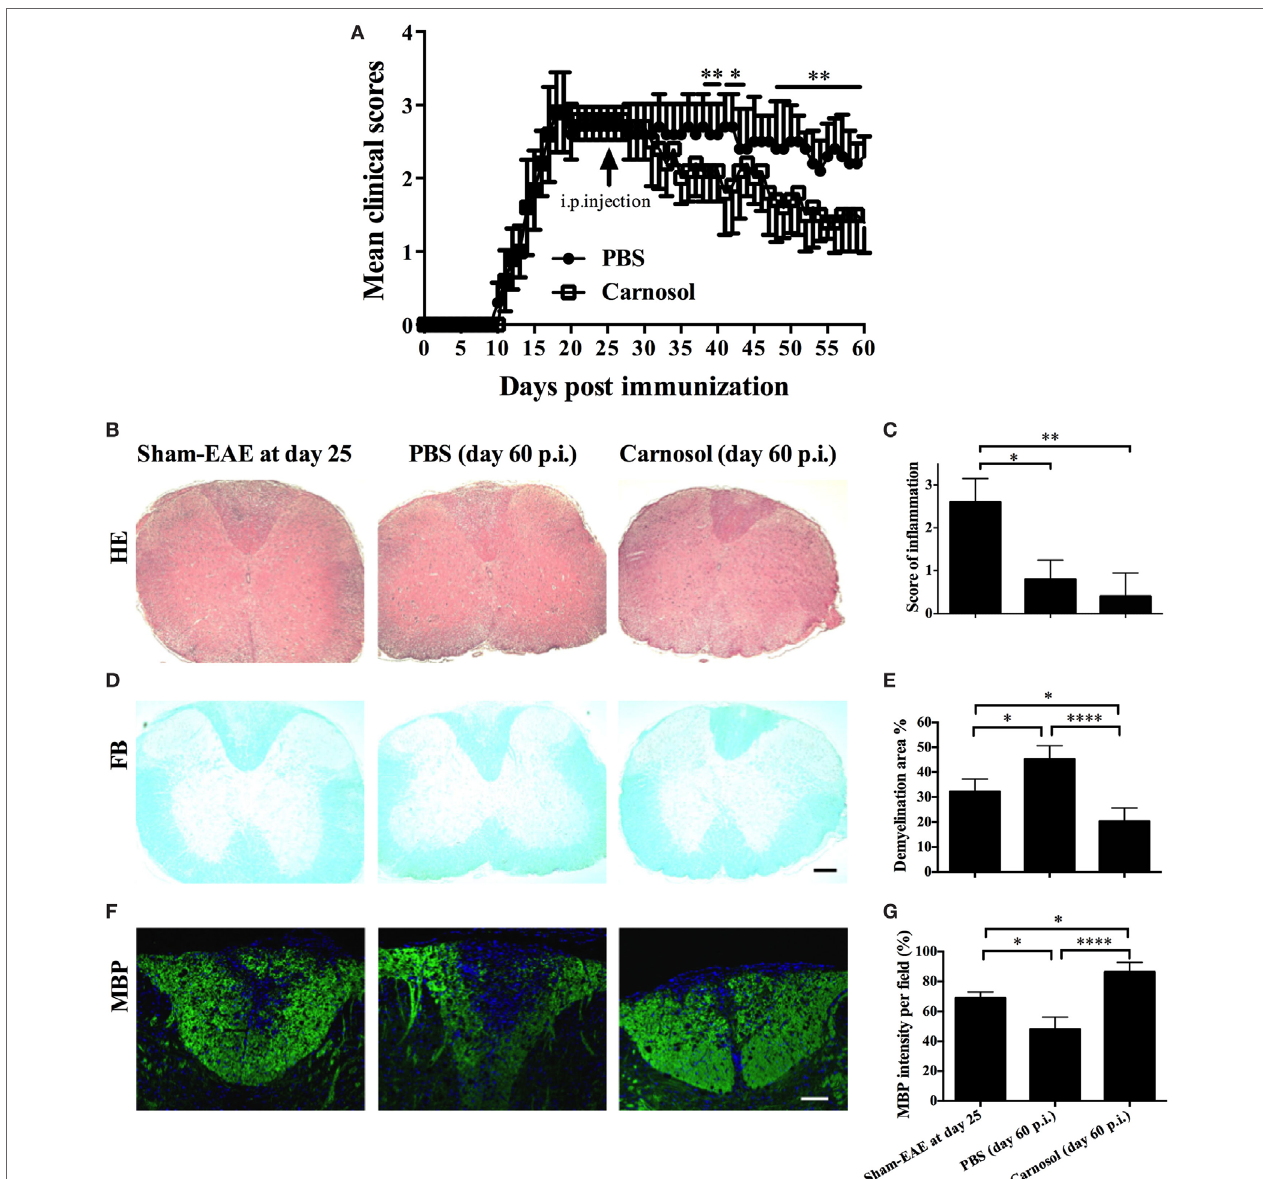
FigUre 6 | Carnosol treatment alleviated the clinical severity of chronic experimental autoimmune encephalomyelitis (EAE) mice. (a) Clinical scores of carnosol- and PBS-treated mice at the chronic stage (treatment starting from day 25 p.i.) of EAE. Mice were sacrificed at day 60 p.i. ( n = 5 each group), and spinal cords were harvested and evaluated for cell infiltration by H&E staining (B) , which was scored on a 0–3 scale (c) , and for demyelination by Luxol fast blue (D) . (e) Demyelination area was measured using Image-Pro Plus software. (F) Sections of lumbar spinal cord from (a) were assayed for demyelination by MBP staining. (g) Quantitative analysis of MBP expression. MBP intensity was measured in the lesion areas in the lumbar spinal cord using Image-Pro. Data represent mean ± SD ( n = 10 each group). Scale bar = 1 mm (B,D) or 100 µm (F) . * p < 0.05, ** p < 0.01, and **** p < 0.0001. Student’s t -test. One representative of three independent experiments is